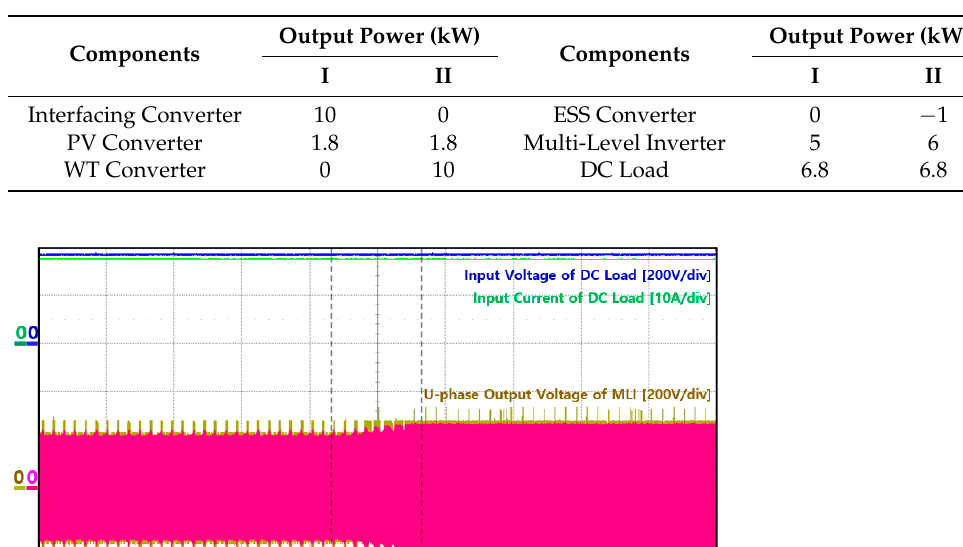
Table 9. Output power of each power conversion devices in mode 9.